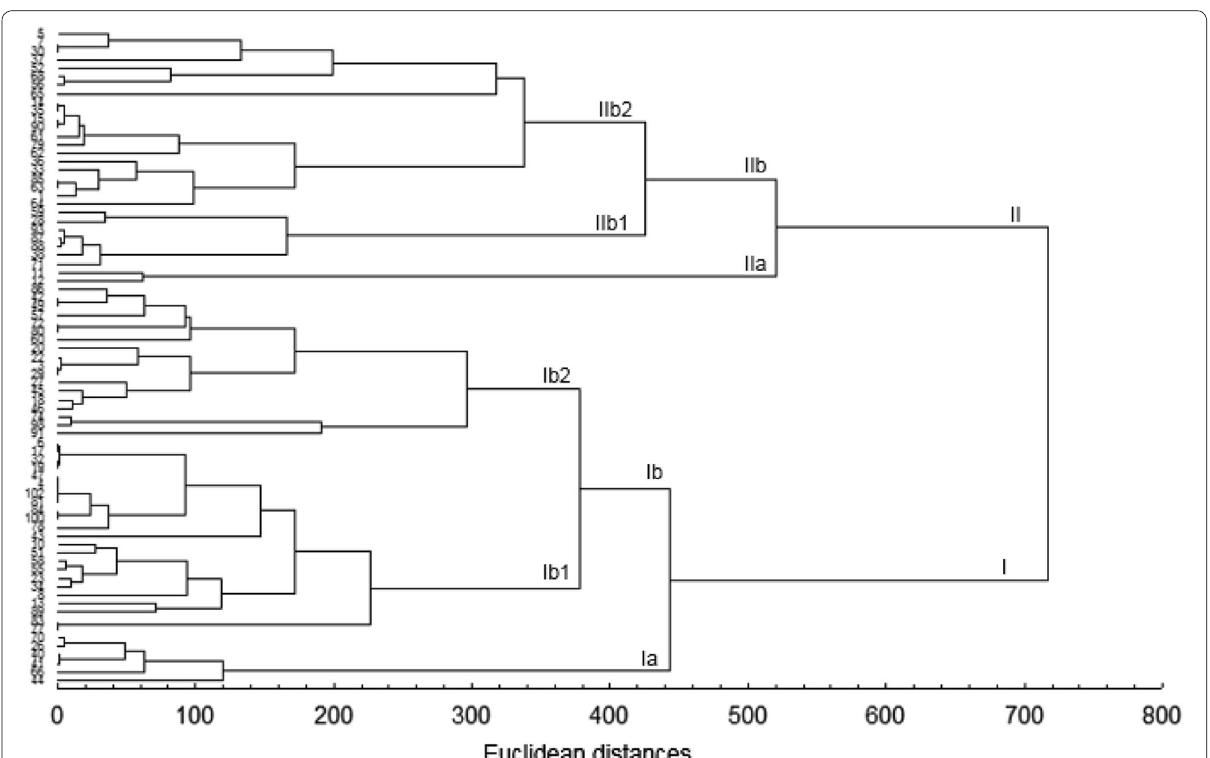
Fig. 4 Dendrogram generated using UPGMA cluster analysis and Euclidean distances based on ecogeographic characterization of sites investi-